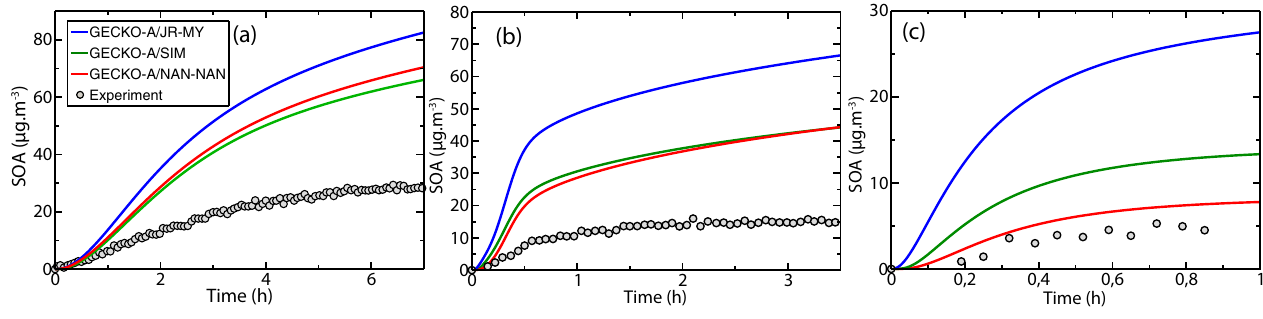
Fig. 5. Time evolution of SOA during α -pinene photo oxidation for (a) the low-, (b) intermediate- and (c) high-NO x experiments. Dots and lines represent, respectively, measurements and values modelled using the various P vap